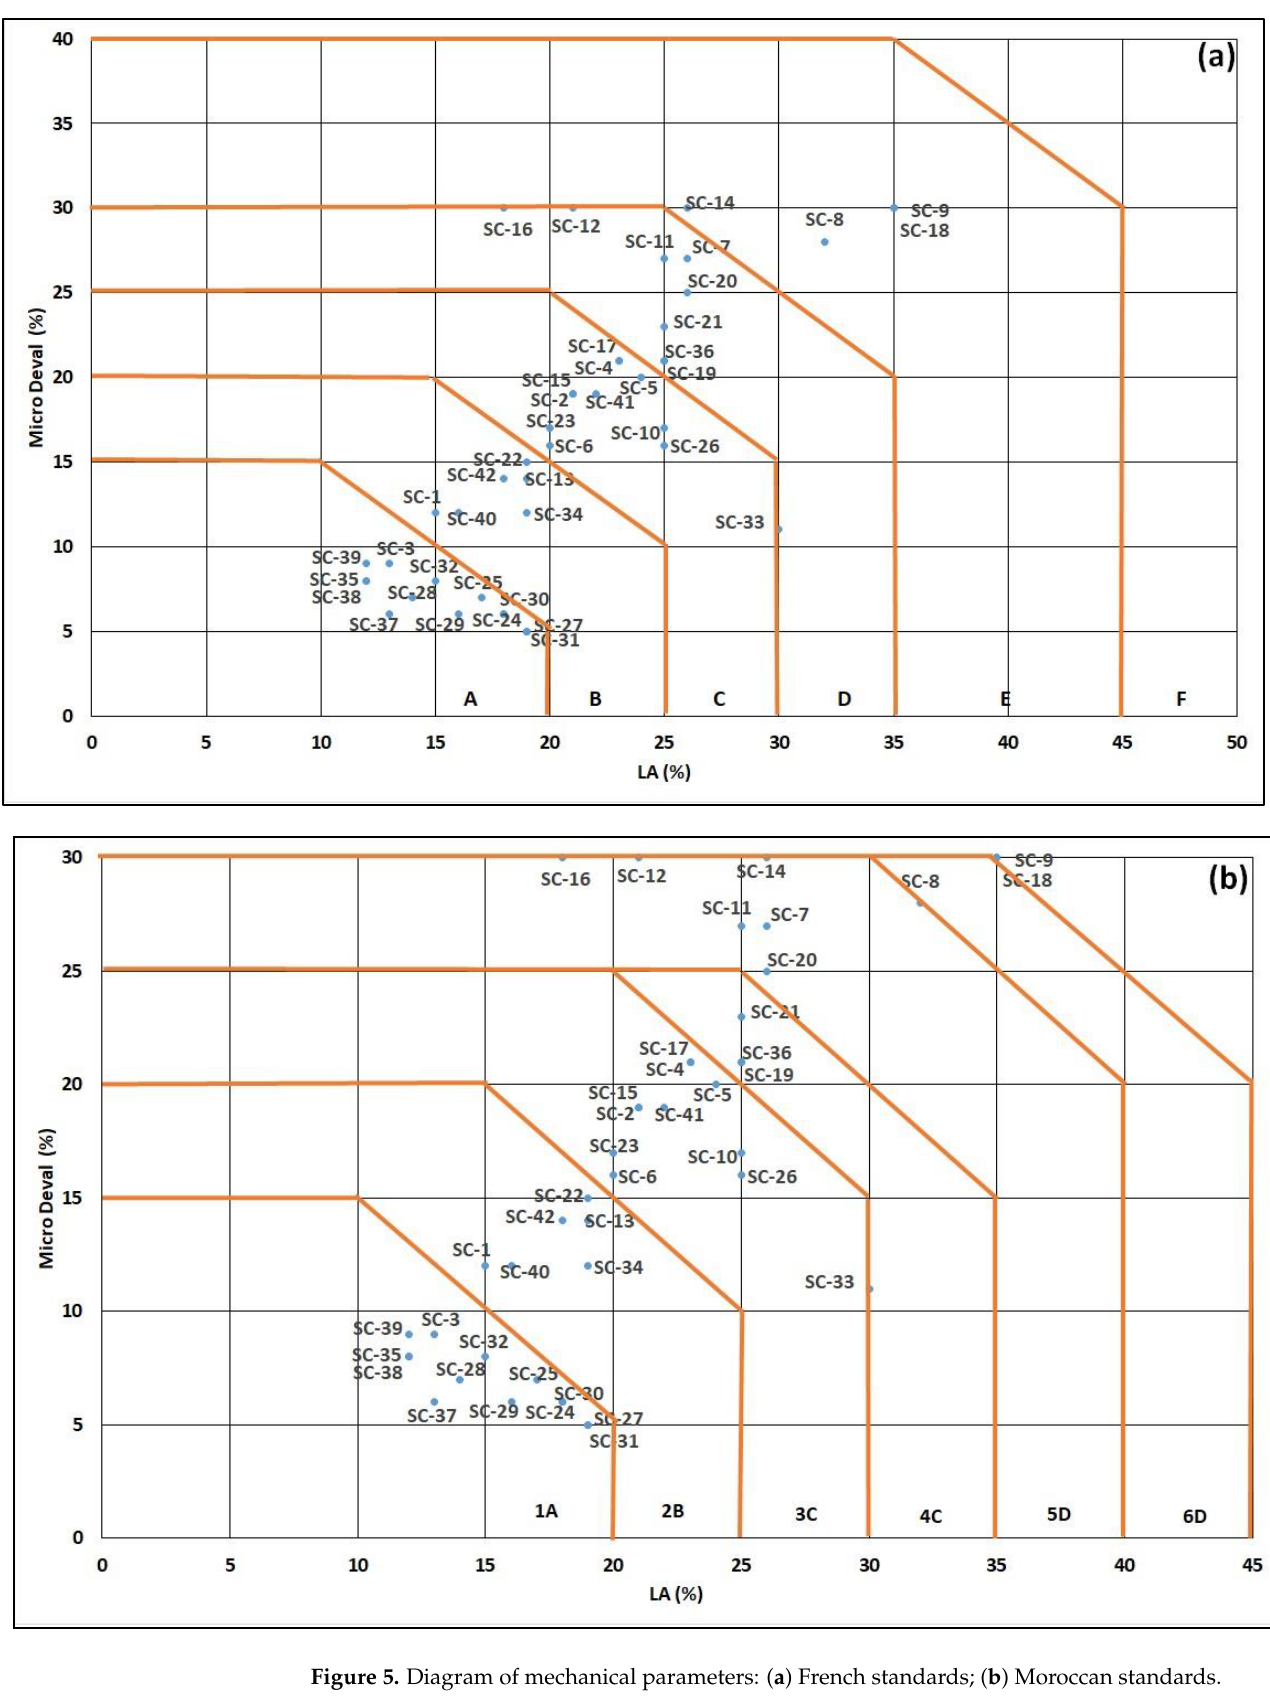
Figure 5. Diagram of mechanical parameters: ( a ) French standards; ( b ) Moroccan standards.